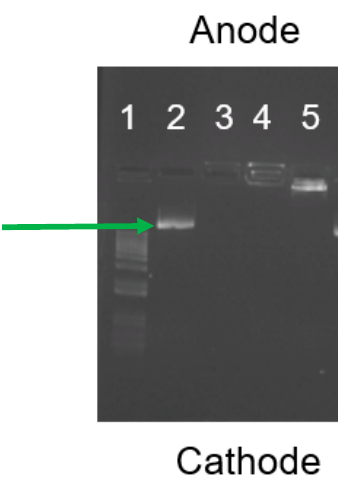
Figure 7. Agarose gel electrophoresis shows the difference in migration of the RP2 when complexed at different N/P ratios, such as 100:1 (lane 3), 10:1 (Lane 4), and 1:1 (lane 5). Lanes 1 and 2 represent the 100 bp ladder and free plasmid (arrow), respectively. The absence of free plasmid bands in lanes 3, 4, and 5 shows that the RP2 is complexed with G4-90/10.